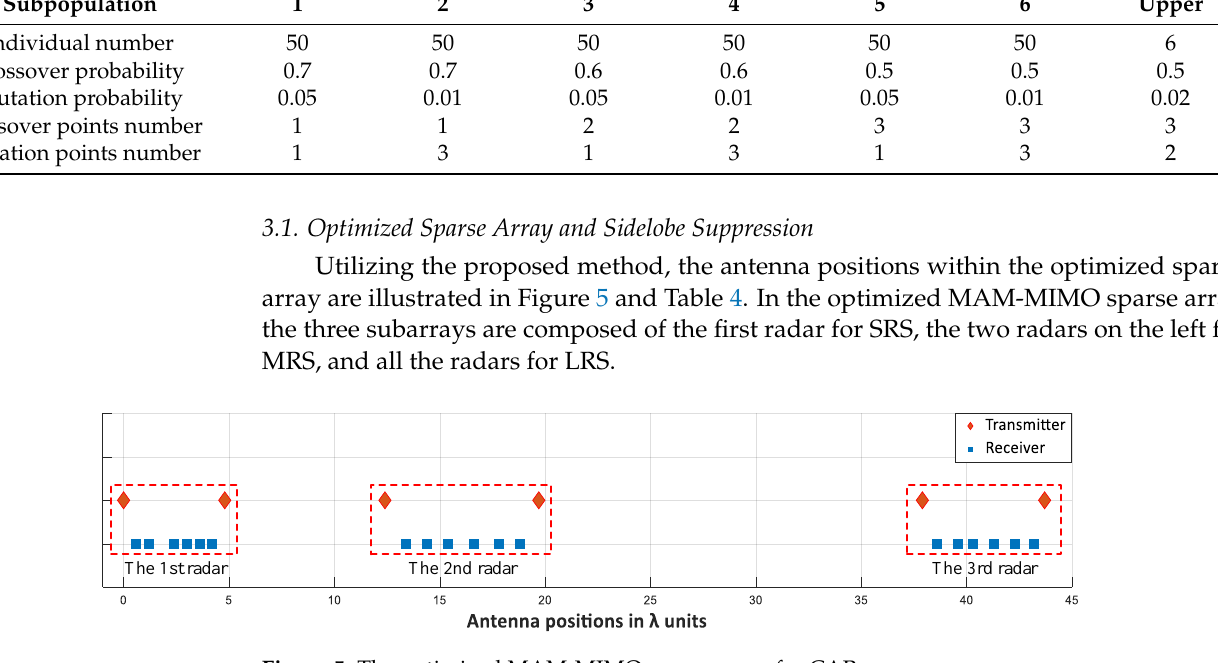
Figure 5. The optimized MAM-MIMO sparse array for CARs. Table 4. Transmitter and receiver positions within the optimized MAM-MIMO sparse array.